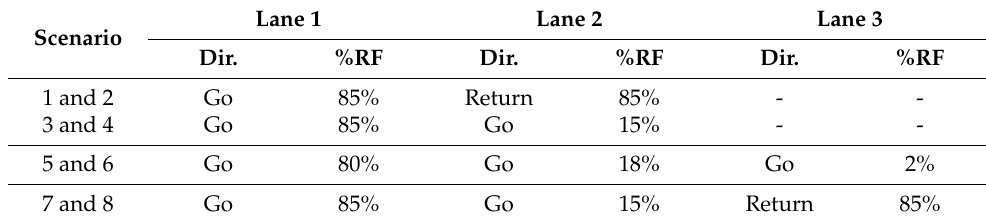
Table 4. Characterization of traffic scenarios (RF = reference flow = 7019 vehicles per